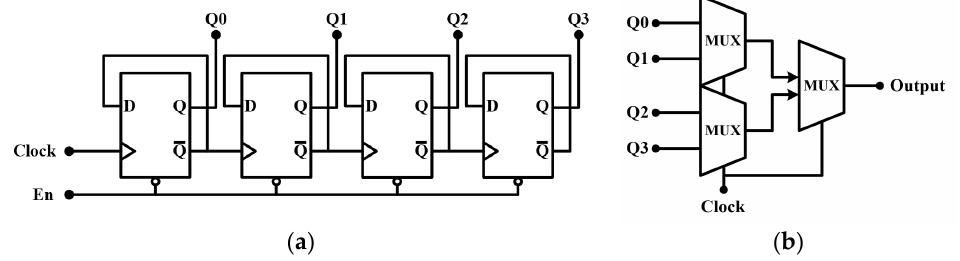
Figure 6. ( a ) 4-bit counter circuit that consists of four D flip-flops ( b ) serializer circuit composed of digital multiplexers.